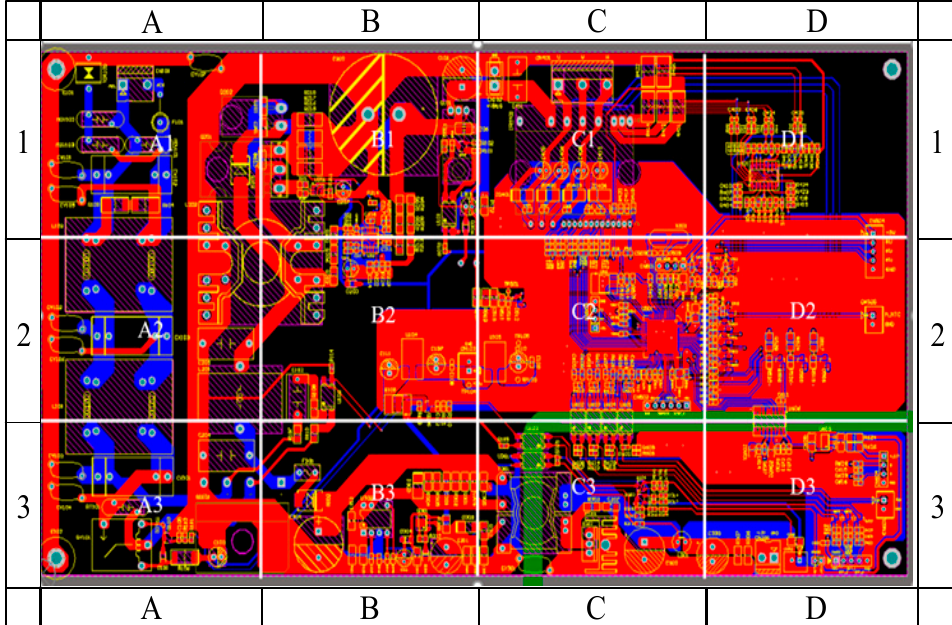
Figure 12. The circuit board of the developed drive is divided into 12 blocks for EMI test.